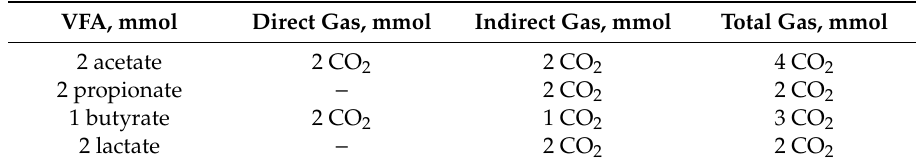
Table 2. Molar proportions (per mmol of hexose) of direct (from microbial fermentation) and indirect (from bu ff ering of acids) gas produced in the rumen fermentation in vitro (according to Beuvink and Spoelstra [31]). VFA, mmol Direct Gas, mmol Indirect Gas, mmol Total Gas, mmol 2 acetate 2 CO 2 2 CO